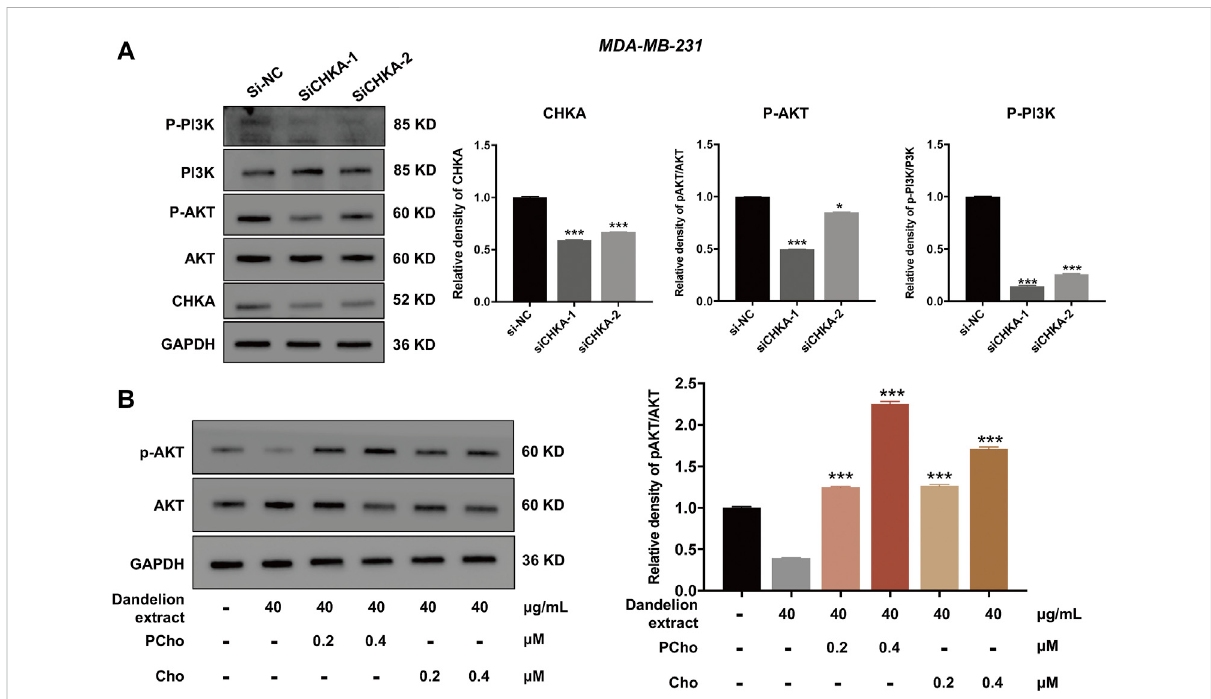
FIGURE 8 Dandelion extract inhibited mRNA and protein expression levels of metabolic-associated proteins and pathways. (A) Inhibition of CHKA expressiondecreasedthephosphorylationlevelsofPI3KandAKT. *p < 0.05,**p < 0.01,***p < 0.00 1vs.si-NC. (B) TheexogenousadditionofChoand PChoreversedthedecreasedphosphorylationlevelsofAKTinMDA-MB-231cells. *p < 0.05,**p < 0.01,***p < 0.00 1vs.dandelionextract(40 μ